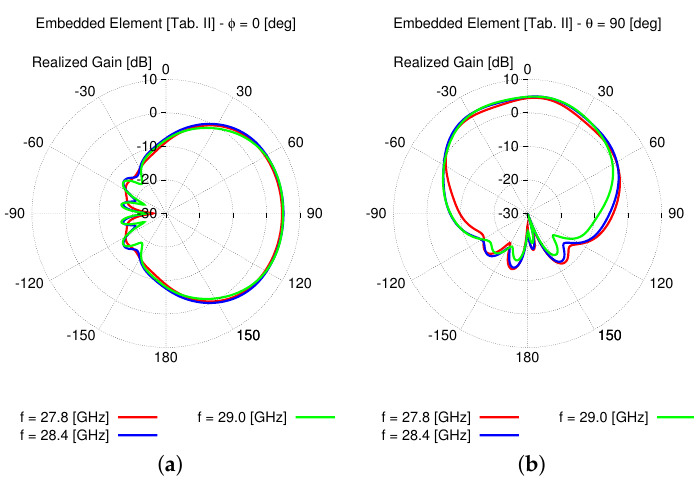
(cid:105) (cid:104) ( p ) ( p ) = [ 27.8, 29.0 ] (GHz))—Polar plot realized f , f max min